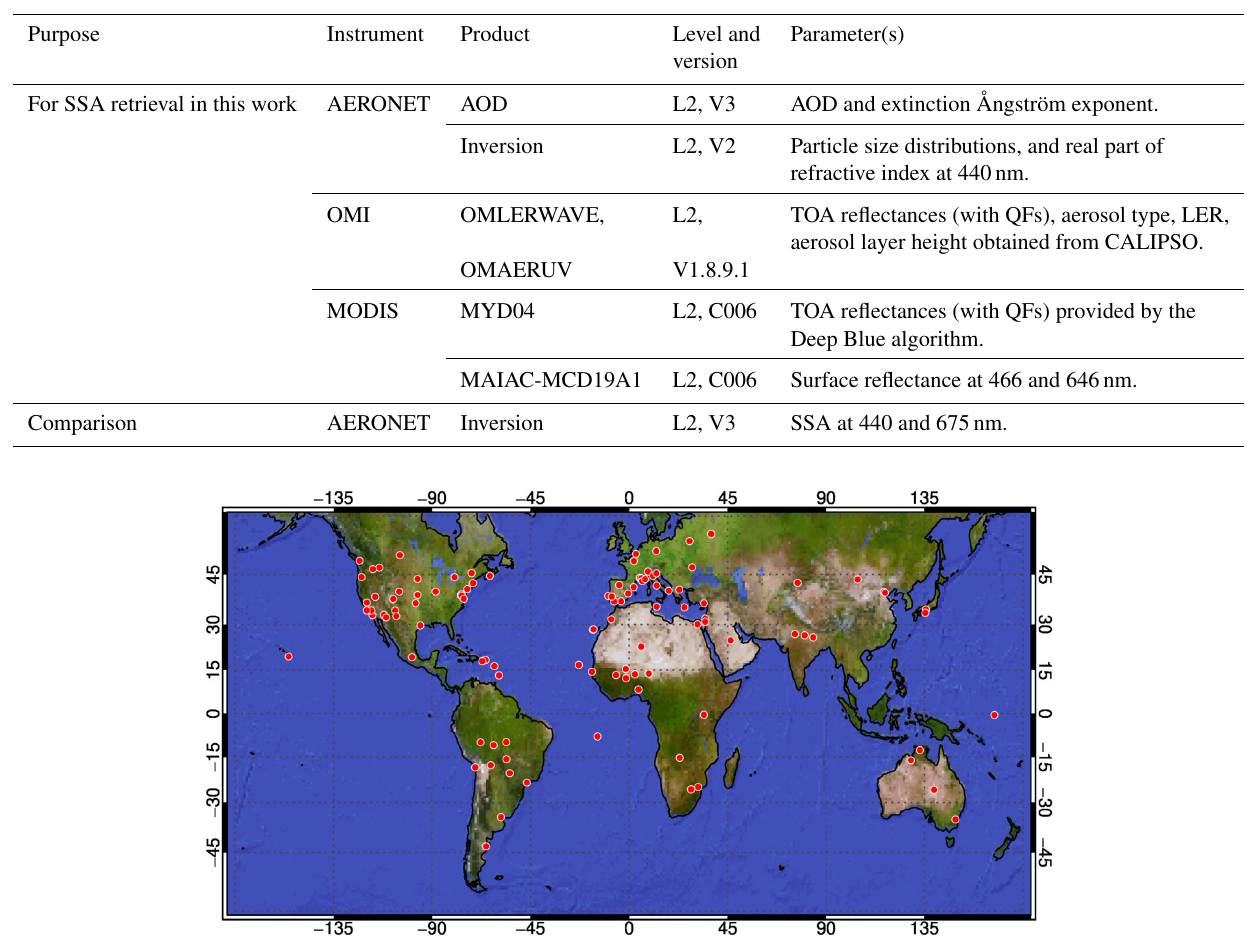
Figure 1. The geo-distribution of AERONET sites whose AOD data are used for the retrieval of spectral aerosol single scattering albedo in this